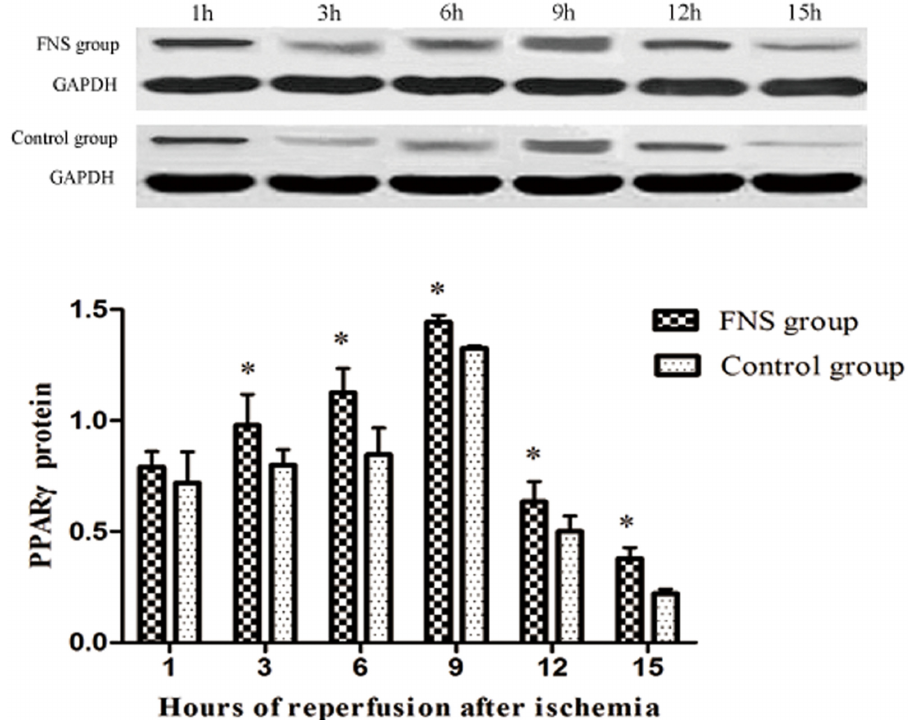
Fig 3. The protein expressions of PPAR γ in cerebral ischemic penumbra. Results are expressed as the mean ± SD. * p < 0.05, vs the control group, n = 5.